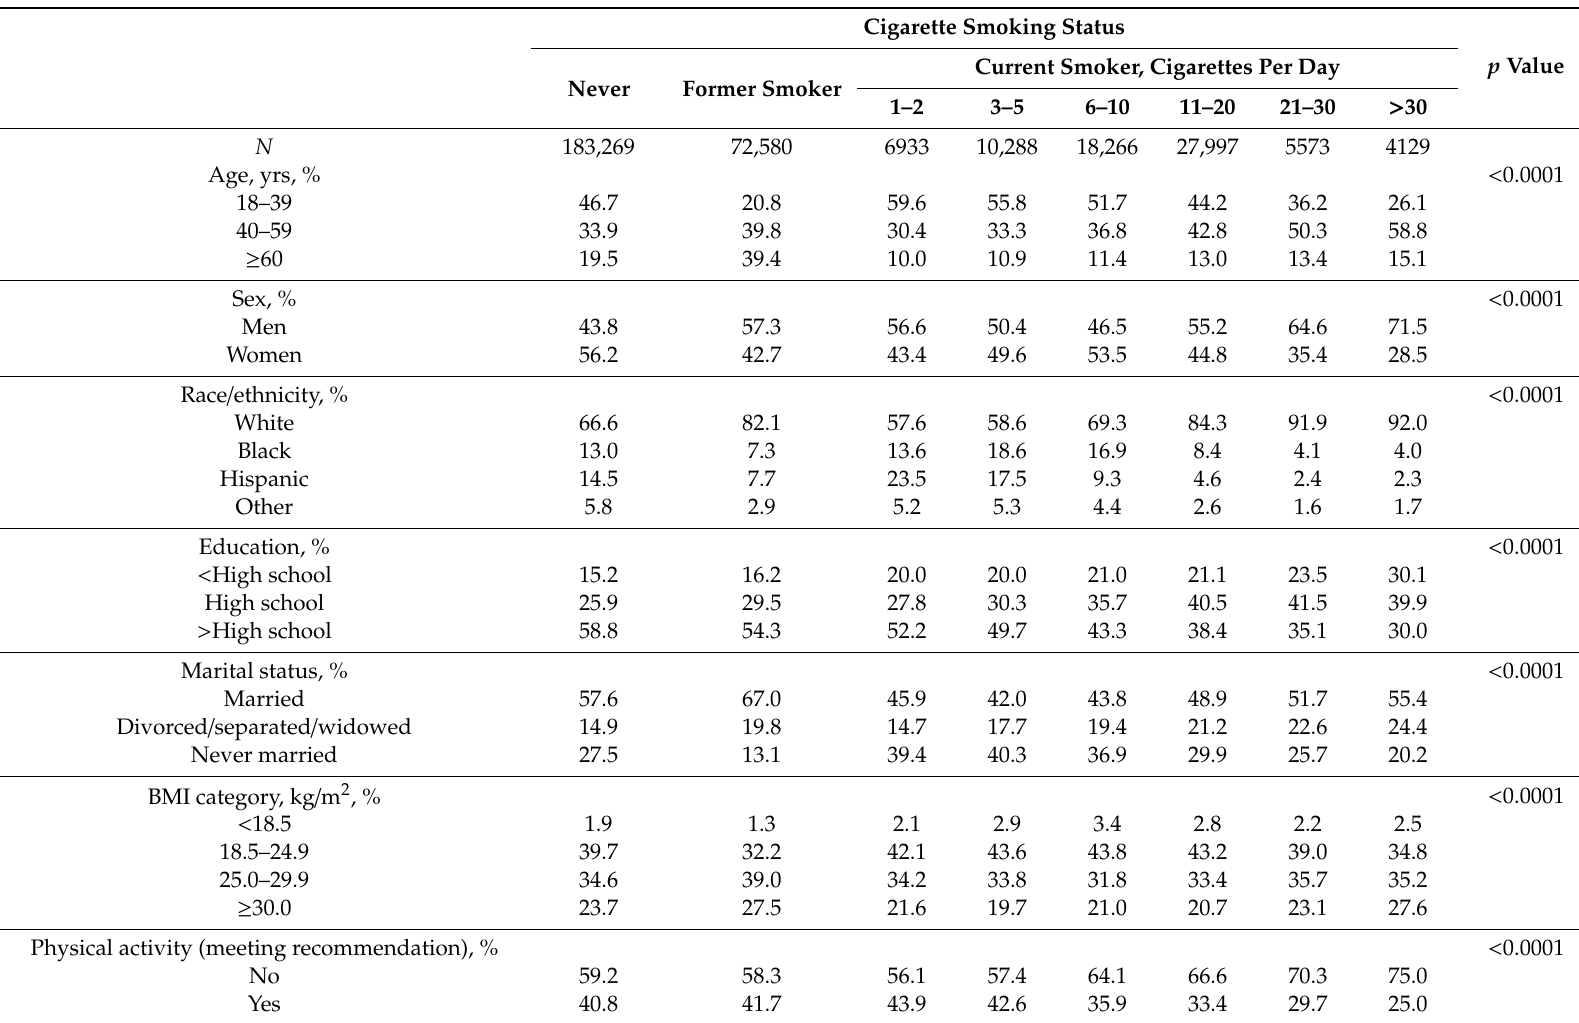
Table 1. Baseline Characteristics according to cigarette smoking status, National Health Interview Survey (NHIS),